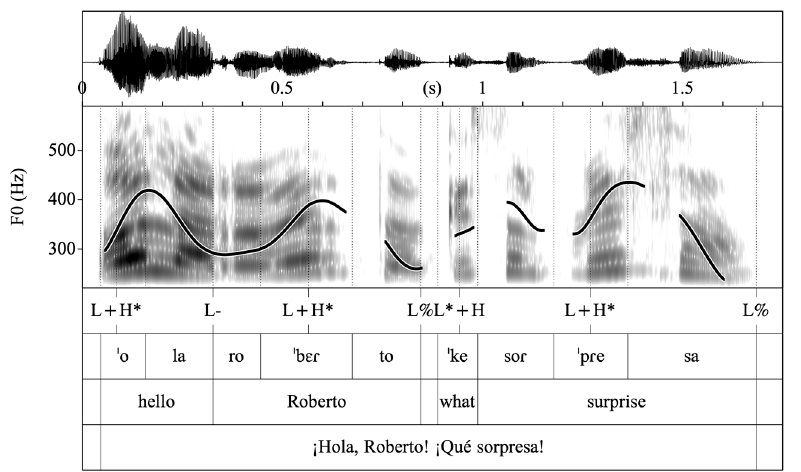
Figure 7. Waveform, spectrogram and F0 trace of the what -exclamative statement Hi, Roberto! What a surprise! in L1 Spanish produced with L+H* L%.